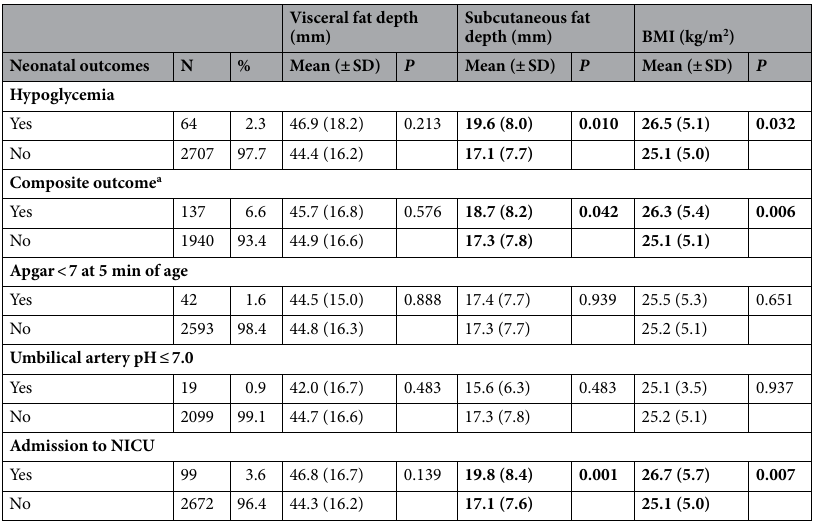
Table 3. Comparison of visceral fat depth, subcutaneous fat depth, and early pregnancy BMI between groups defined by neonatal outcomes. Data were analyzed using t-tests. Significant results are in bold. NICU neonatal intensive care unit, BMI body mass index. a Apgar < 7 at 5 min of age, or umbilical artery pH ≤ 7.0, or admission to